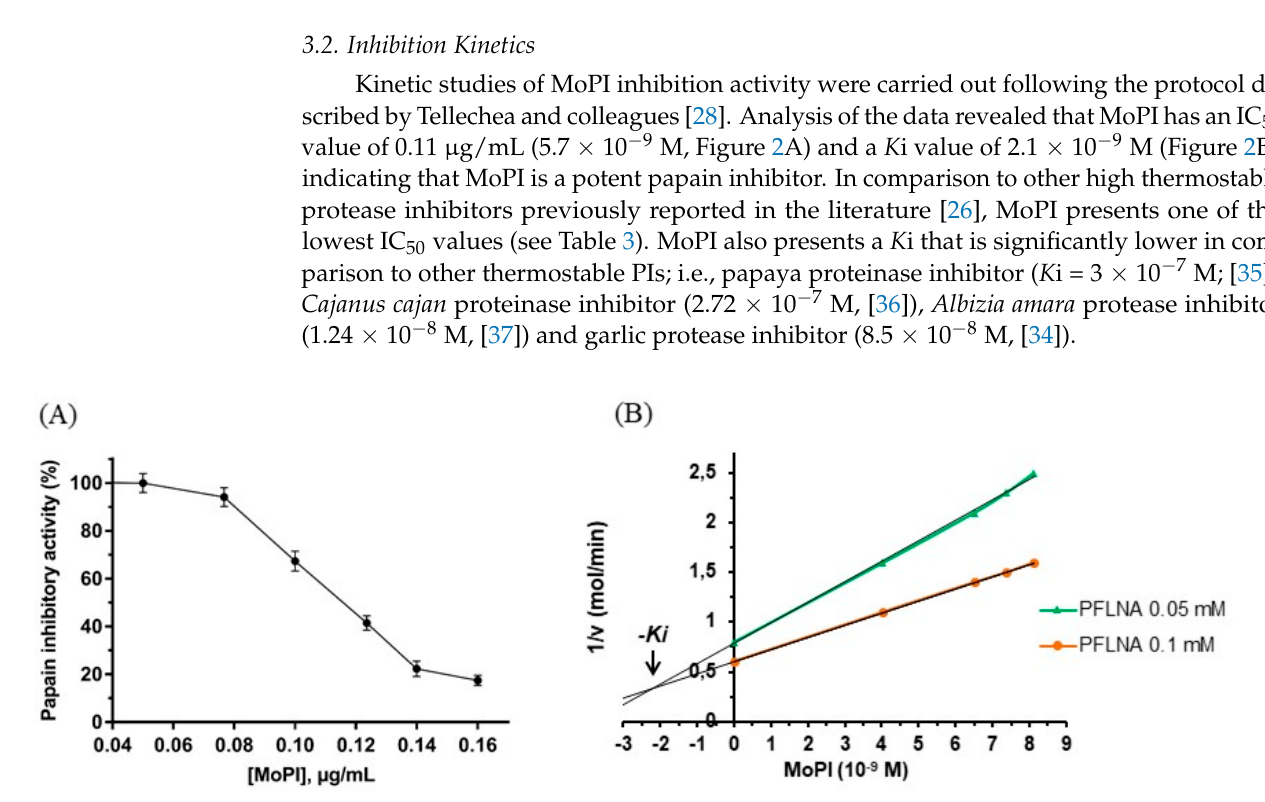
Figure 2. Kinetic studies on M. oleifera papain inhibitor. ( A ) Dose response curve for the half maximal inhibitory concen- tration (IC 50 ) determination. ( B ) Dixon plot (1/v vs. [I]) for identification of the Ki . Each point represents the mean of three estimates.